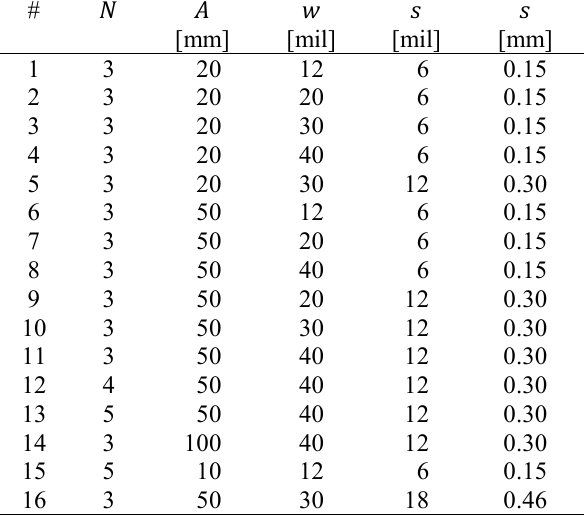
Table 3: Dimensional design parameters of 16 reader